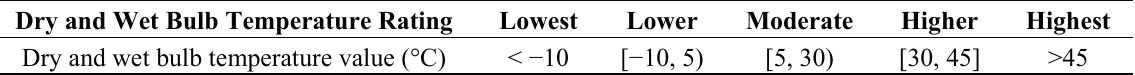
Table 2. Fuzzy classification of dry and wet bulb